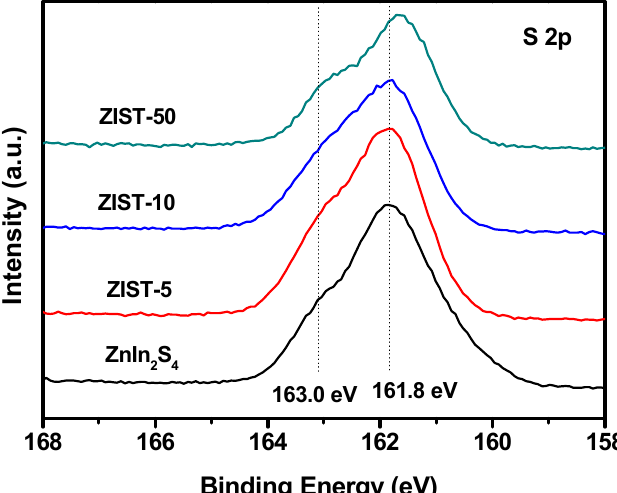
Figure 8. XPS S 2p spectra of ZnIn 2 S 4 and ZnIn 2 S 4 /Ti 3 C 2 composites with different Ti 3 C 2 content.